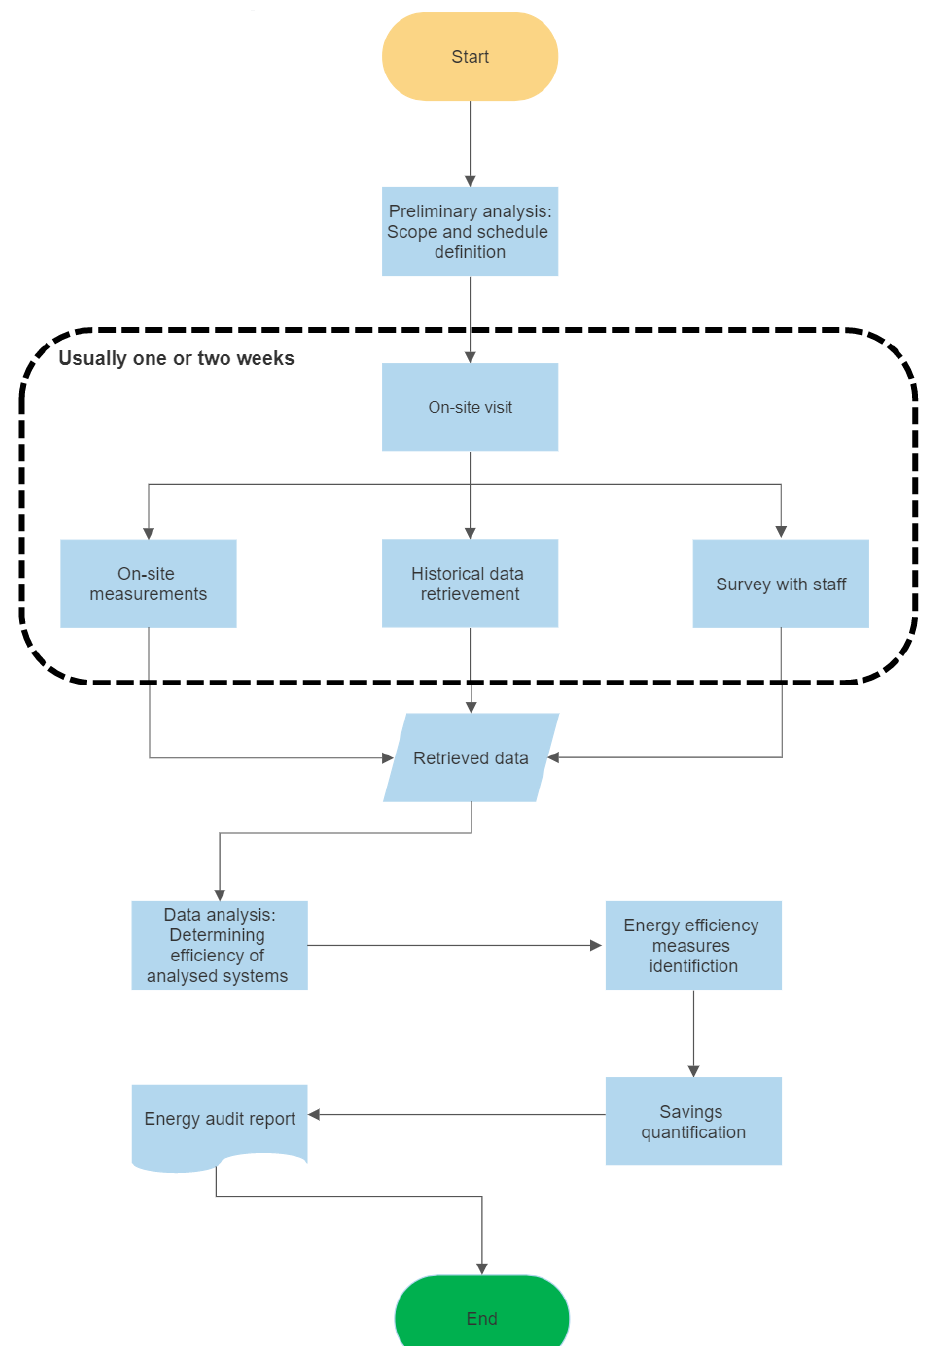
Figure 1. Flowchart process of a standard energy audit.